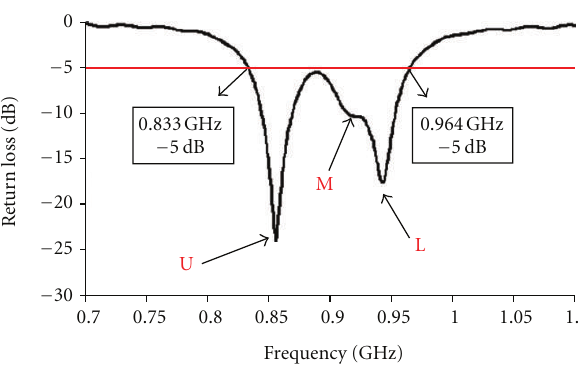
Figure 5: The simulated frequency response of return loss.